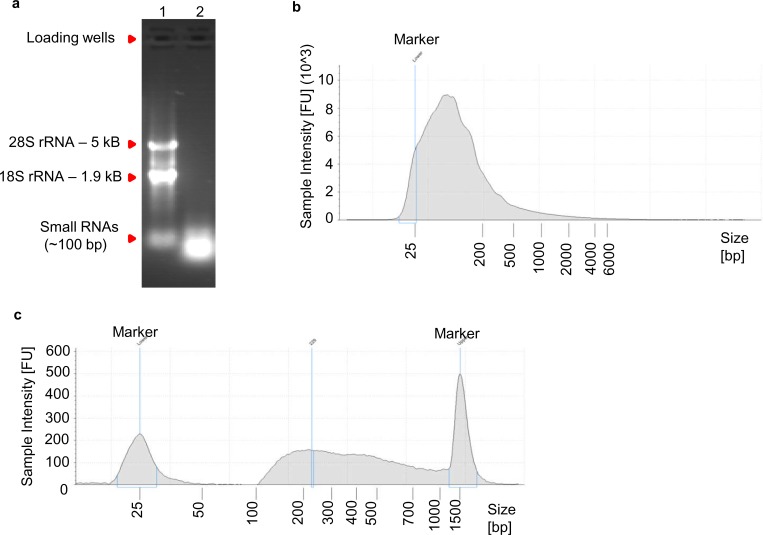
Long RNA fragments crosslinked to SND1 are enriched over shorter fragments during RIP.(a) Following sonication of formaldehyde-fixed TREx BCBL1-Rta cells, proteins were removed by proteinase K treatment and cross-links were reversed. Sonicated RNA was then isolated with Trizol LS and 1 µg was separated on a 1.2% (w/v) agarose gel containing 0.1 µg/ml of ethidium bromide. 1 µg of intact total RNA was used as a size marker. Lane one contained intact total RNA. Lane two contained sonicated total RNA. rRNA, ribosomal RNA. (b) 2200 TapeStation trace of sonicated total RNA (input) before RIP. The majority of the fragments are between 50 and 200 base pairs (bp) in length with a small tail of fragments of larger sizes (>500 bp). (c) 2200 TapeStation trace of cDNA library built from the immunoprecipitated RNA fragments after RIP. Note that the heat fragmentation step before cDNA synthesis was omitted to evaluate the true size of the immunoprecipitated RNA. Fragments smaller than 100 bp were totally depleted, in contrast a large tail of fragments that reached 1 kB in length was evident. Due to the large size of RNA fragments observed after SND1 immunoprecipitation, for all deep-sequencing of RIP samples used in this study, isolated RNA from RIP samples was fragmented for 7 min at 94°C before first strand synthesis.